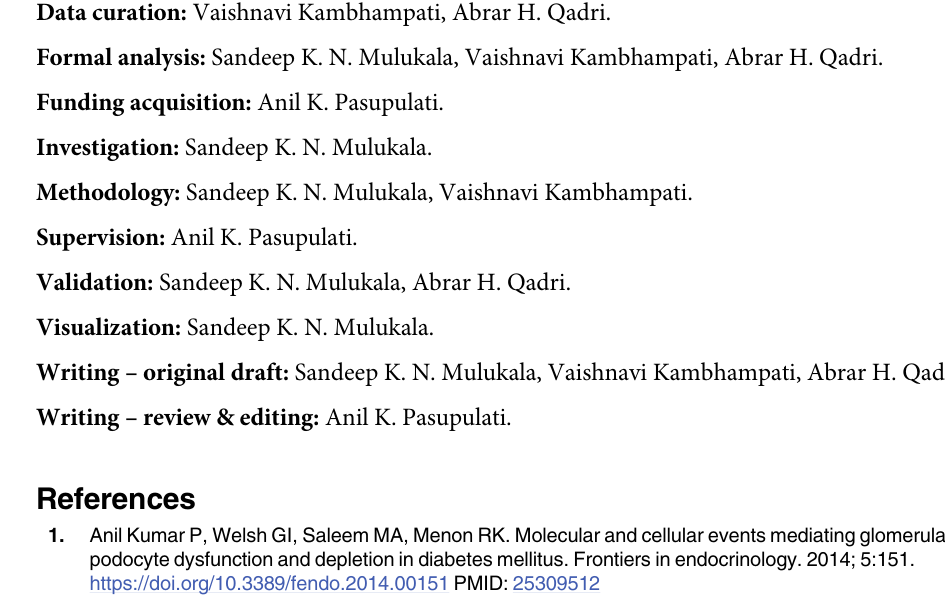
S1 Table. Amino acid residues predicted as intrinsically unstructured regions (IURs) and IUR-binding domain (BD) by the DISOPRED 3.1 tool of the PSI-PRED server the slit-dia- phragm proteins and their orthologs in various metazoans. S2 Table. DISOPRED 3.1 prediction confidence for each residue in Nephrin, KIRREL1, CD2AP, podocin, and TRPC6 and their orthologs sequences. A predicted threshold value of � 0.5 for residue indicates it be intrinsically